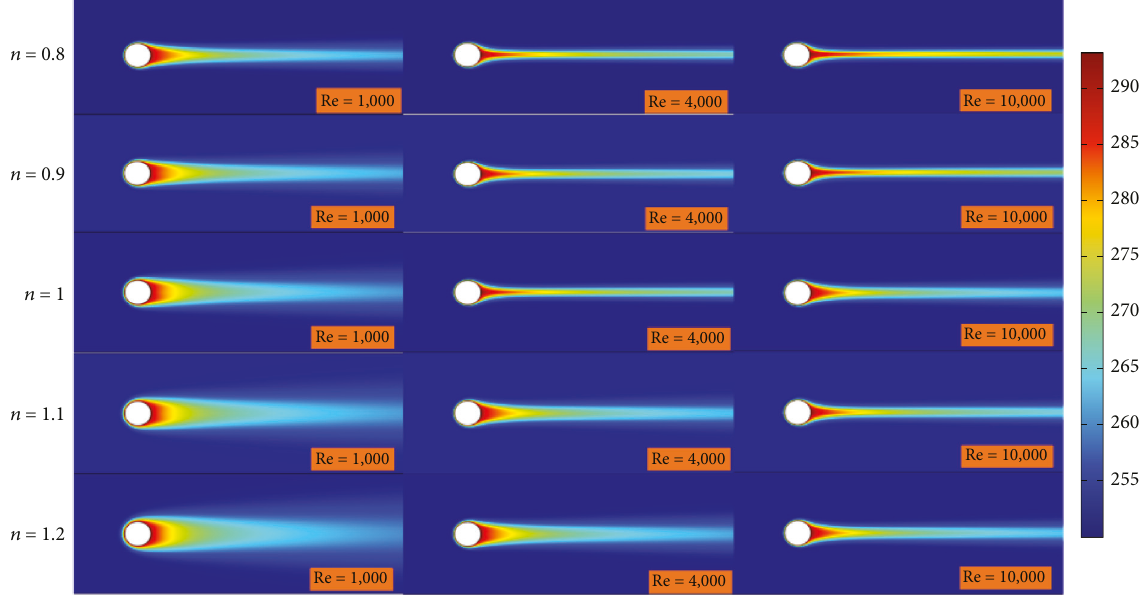
Figure 10: Contours of temperature for r � 0 . 1.